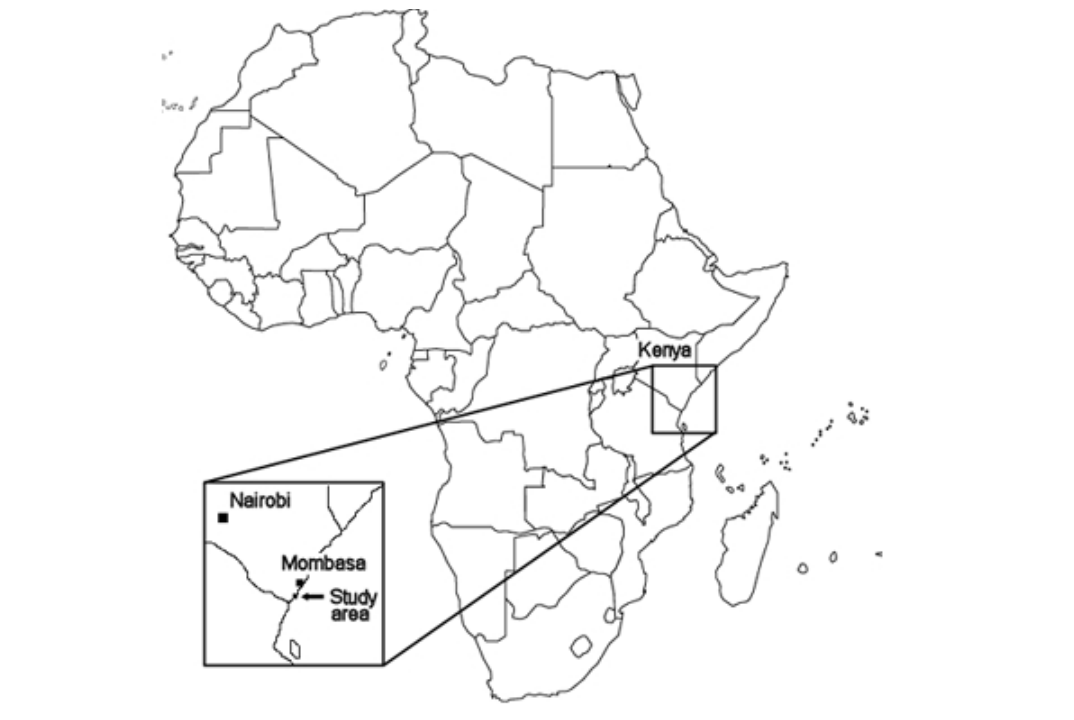
Fig. 1. Map of the study area with the target community indicated in the inset of the left-hand corner. The area is located on the southern Kenyan coast at 4º25'S and 39º50'E, approximately 50 km south of